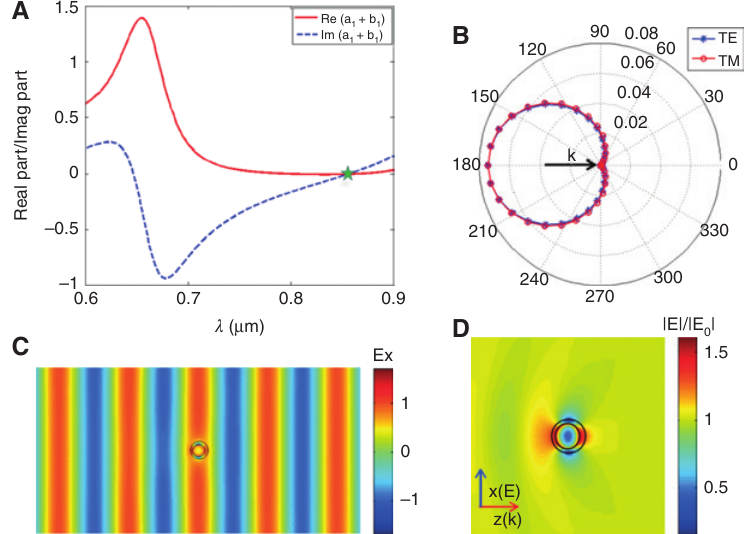
+ b ) for the used core-shell spherical nanoparticle as a function of the incident 1 1